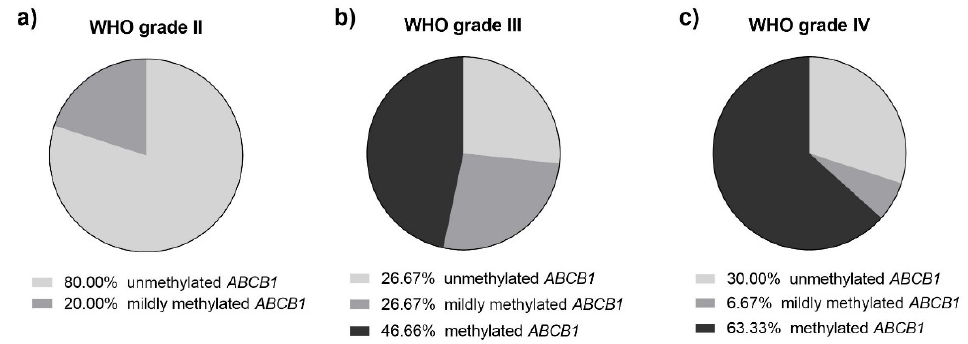
Figure 6. Pie charts presenting the percentage of tumor samples with unmethylated, mildly meth- ylated, or methylated ABCB1 promoter among patients with ( a ) WHO grade II, ( b ) WHO grade III, and ( c ) WHO grade IV gliomas.